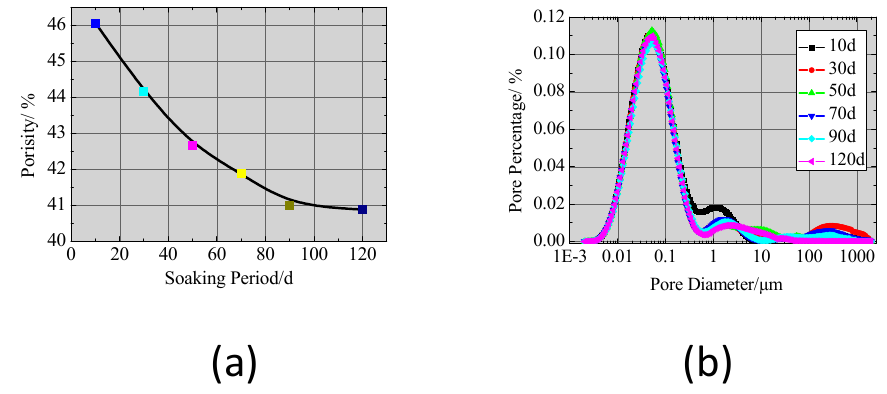
Figure 10. CPB mass ( a ) porosity vs. soaking period and ( b ) pore size distribution.